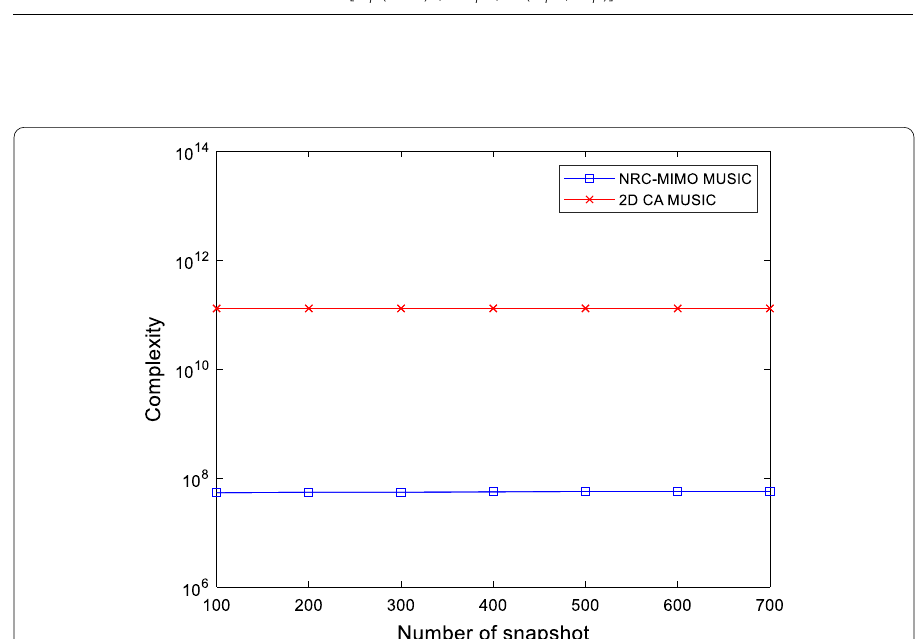
Fig. 2 The computational complexities of different methods versus